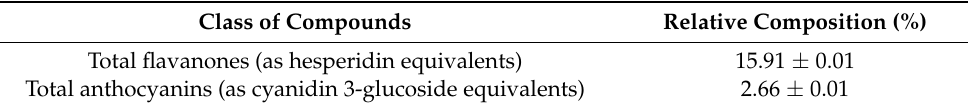
Table 1. Chemical composition of red orange and lemon extract (RLE) used as an oral food supple- ment in this